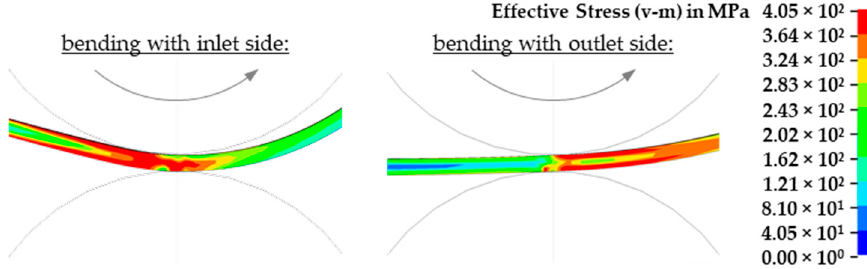
Figure 4. Influence of the bending side on the forming behavior of a plate.